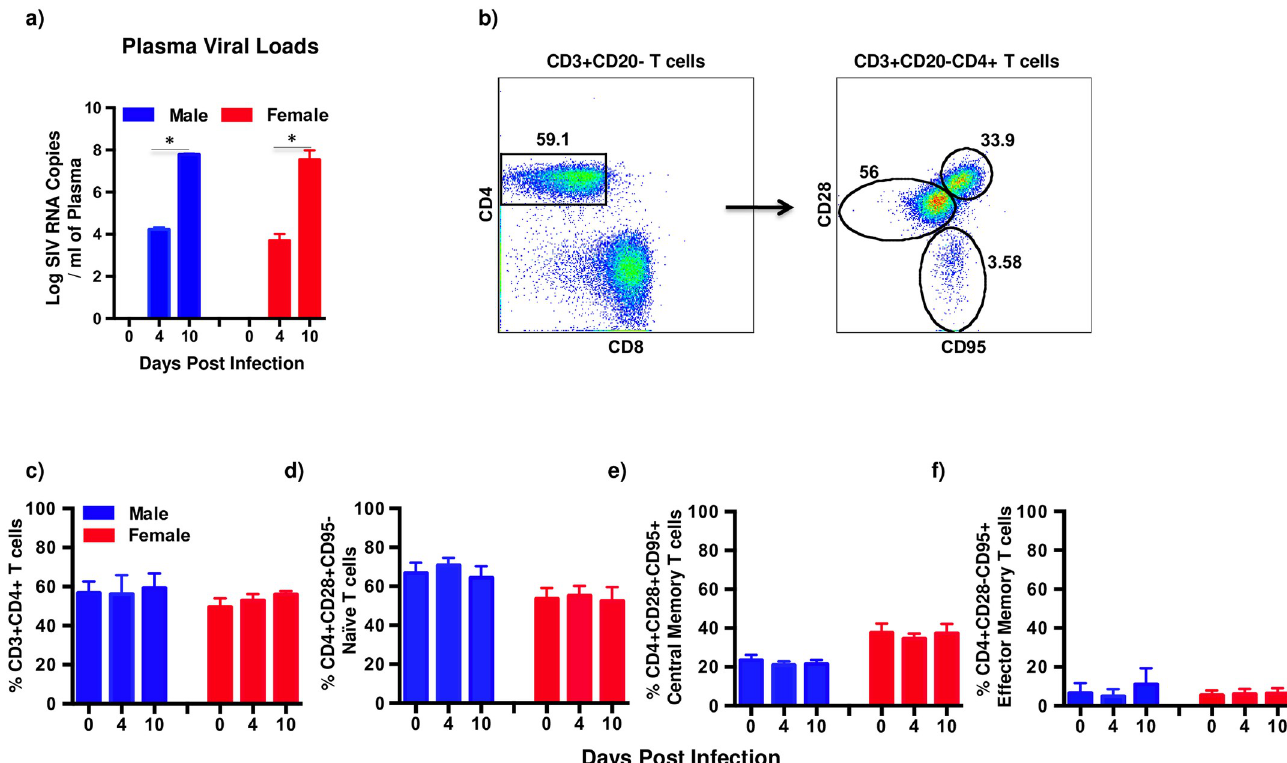
Fig 1. Plasma viral loads and CD4 T cell dynamics are similar in male and female macaques. (a) Plasma viral loads (Limit of detection is 30 copies /ml of plasma) in male (n = 4) and female (n = 4) macaques at day 4 and 10 post SIV infection (PI). (b) Representative dot plots showing the discrimination of CD4 T cells and it subsets in peripheral blood. Na ï ve and memory CD4 T cells were discriminated based on the differential expression of CD28 and CD95 on CD4 T cells. The proportion of peripheral blood (c) CD3+CD20-CD4 T cells, (d) CD4+CD28+CD95- na ï ve CD4 T cells, (e) CD4+CD28+CD95+ central memory CD4 T cells, and (f) CD4+CD28-CD95+ effector memory CD4 T cells at day 0, 4 and 10 PI in male (n = 4) and female (n = 4) macaques. Error bars represent standard error.